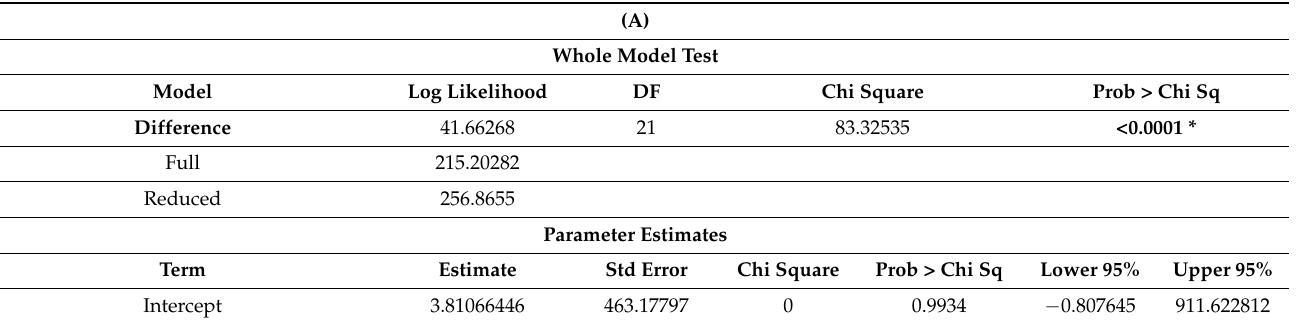
Table 3. ( A ) Logistic Regression Output for DV2 (Part 1). ( B ) Logistic Regression Output for DV2: Odds of User vs. Non-User (Part